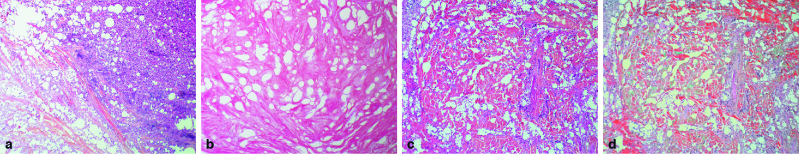
Haematoxylin, phloxine and saffron stained-images of specimen sampled from the ulcer displaying tissue abscess formation (a) and devitalization (b). Numerous micro- and macrovacuoles (c) without refractile or refringent material (d) are consistent with amorphous material deposition.